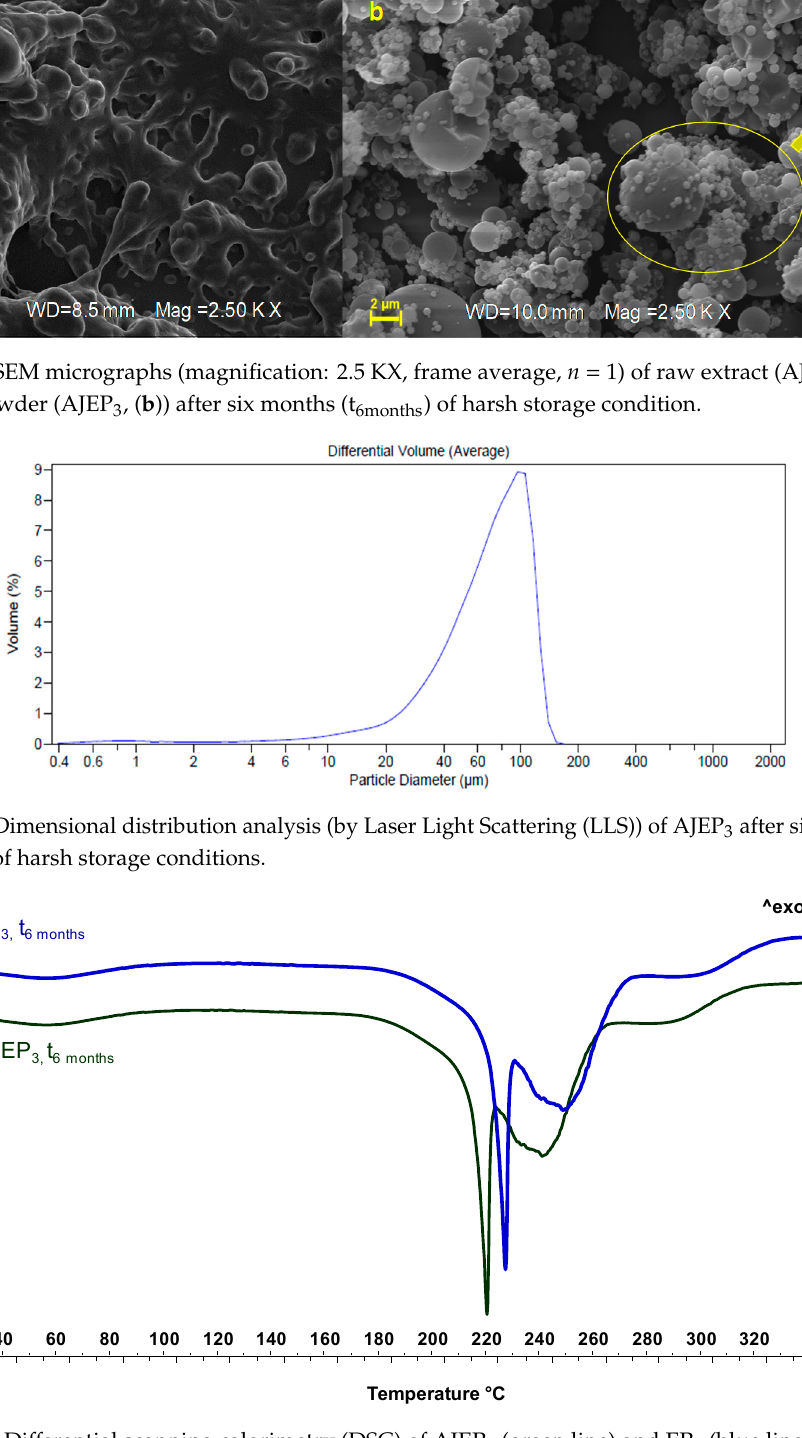
Figure 10. Differential scanning calorimetry (DSC) of AJEP 3 (green line) and EP 3 (blue line) after six months (t 6months ) of harsh storage conditions.